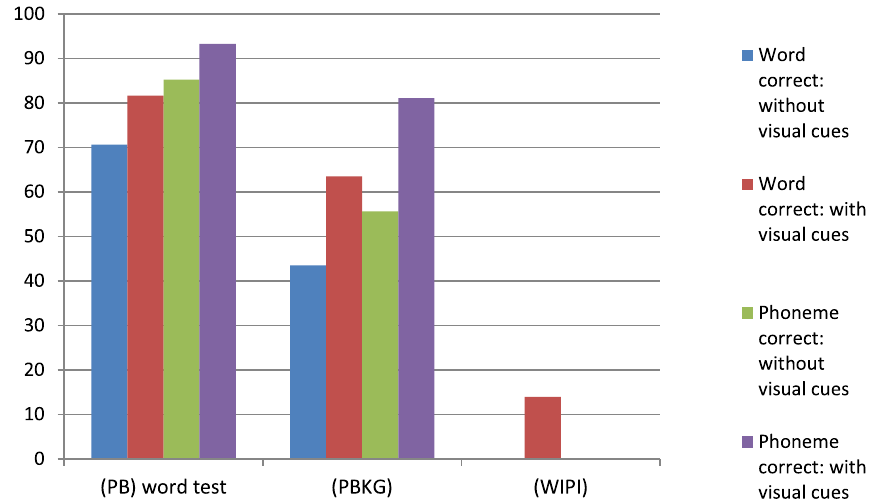
Fig. 6 Mean of different monosyllabic word tests in children